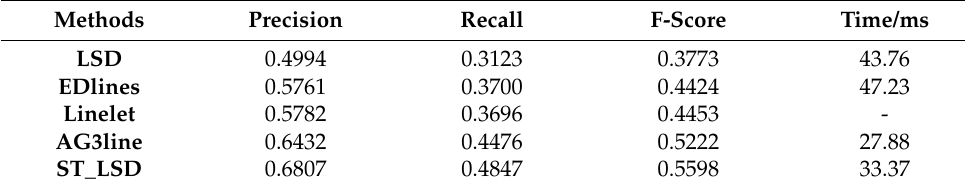
Table 1. Performance of different methods on the MNS-LS